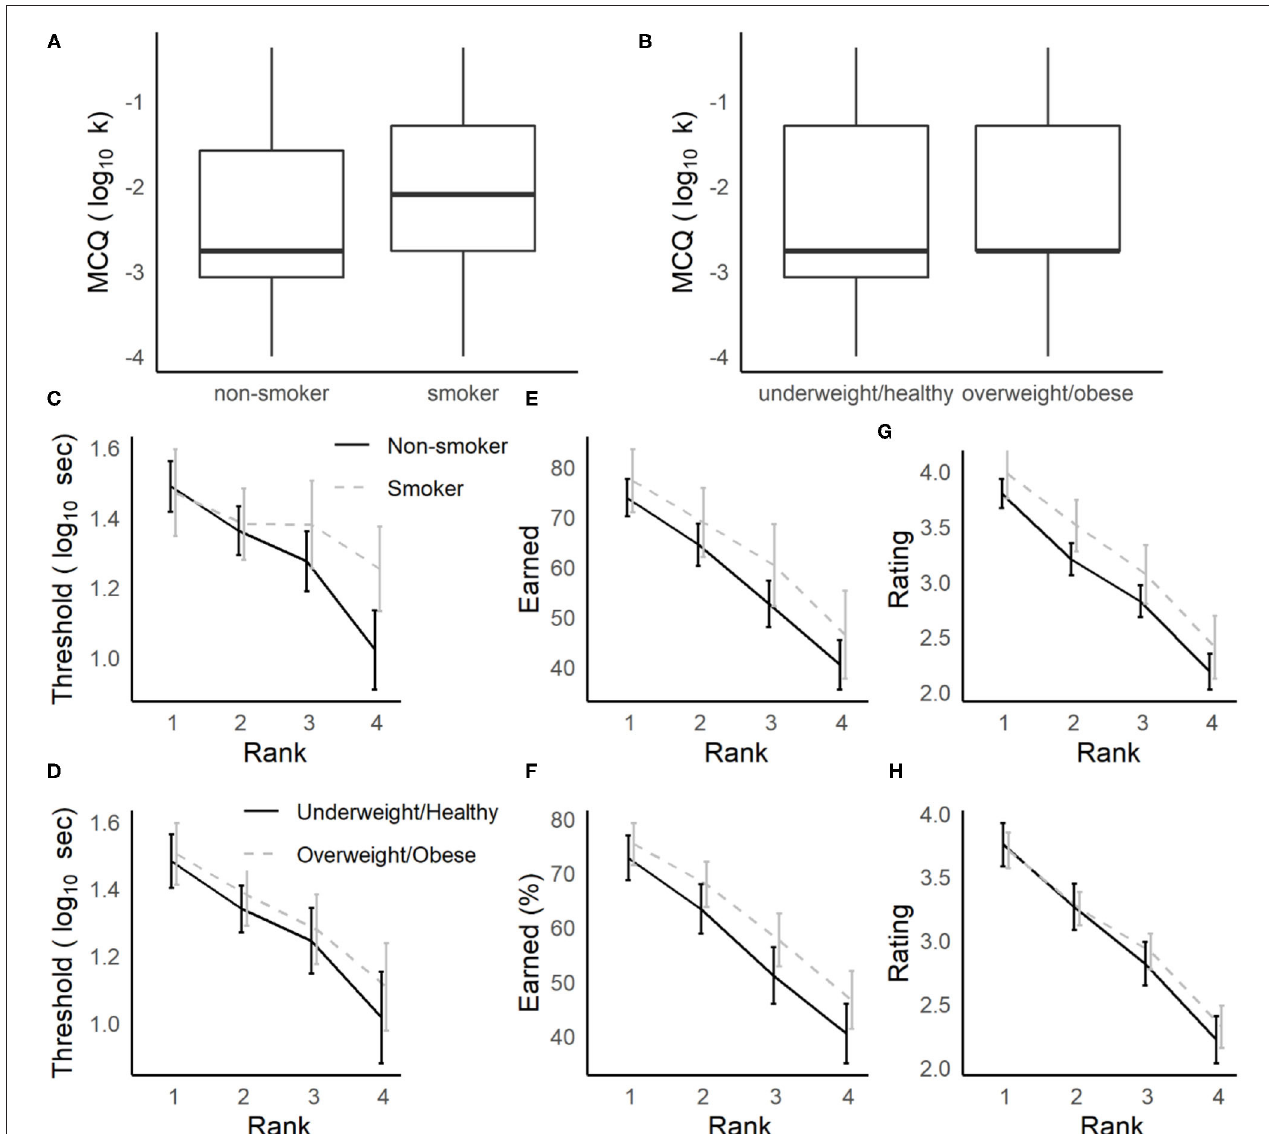
FIGURE 3 | Relationships between delay-discounting and foraging measures to smoking status and obesity. (A,B) Smokers more strongly discounted hypothetical money offers in the MCQ (A) , and overweight/obese individuals did not (B) . (C–H) During foraging, delay thresholds were not strongly related to smoking (C) or BMI (D) . Smokers (E) and overweight/obese individuals (G) tended to earn more rewards (non-significant), but in smokers this trend could be explained by higher subjective ratings of the rewards on the Movie Row task (G) , while BMI group differences were not related to movie ratings (H)